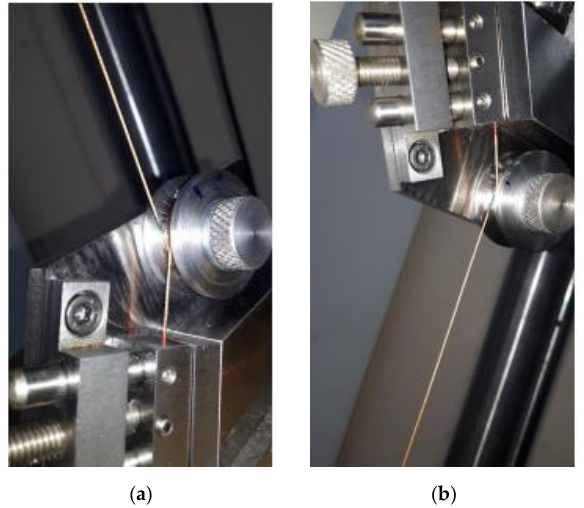
Figure 6. Markings of cord gauge length in the ( a ) lower and ( b ) upper holder.